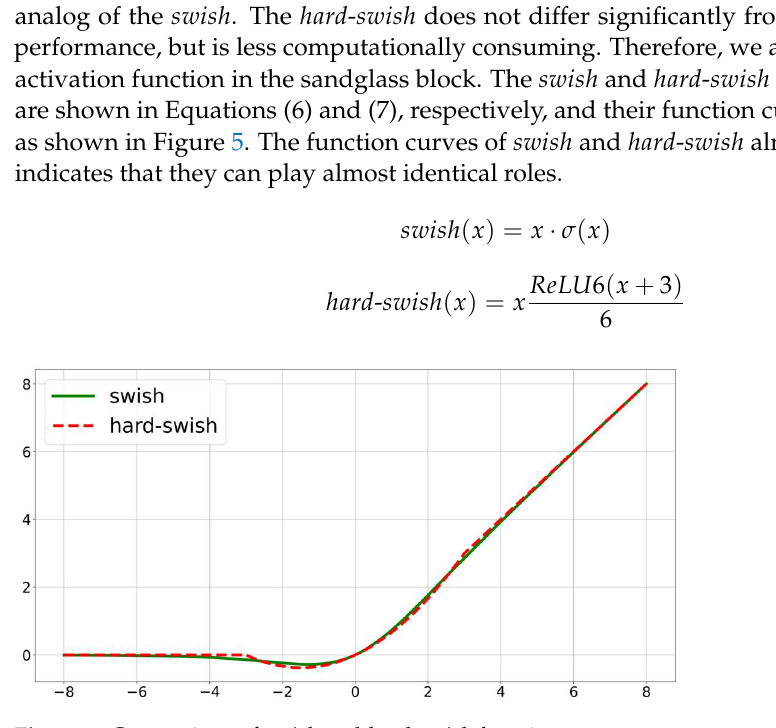
Figure 5. Comparison of (cid:1871)(cid:1875)(cid:1861)(cid:1871)ℎ and ℎ(cid:1853)(cid:1870)(cid:1856) - (cid:1871)(cid:1875)(cid:1861)(cid:1871)ℎ function curves. Figure 5. Comparison of swish and hard - swish function